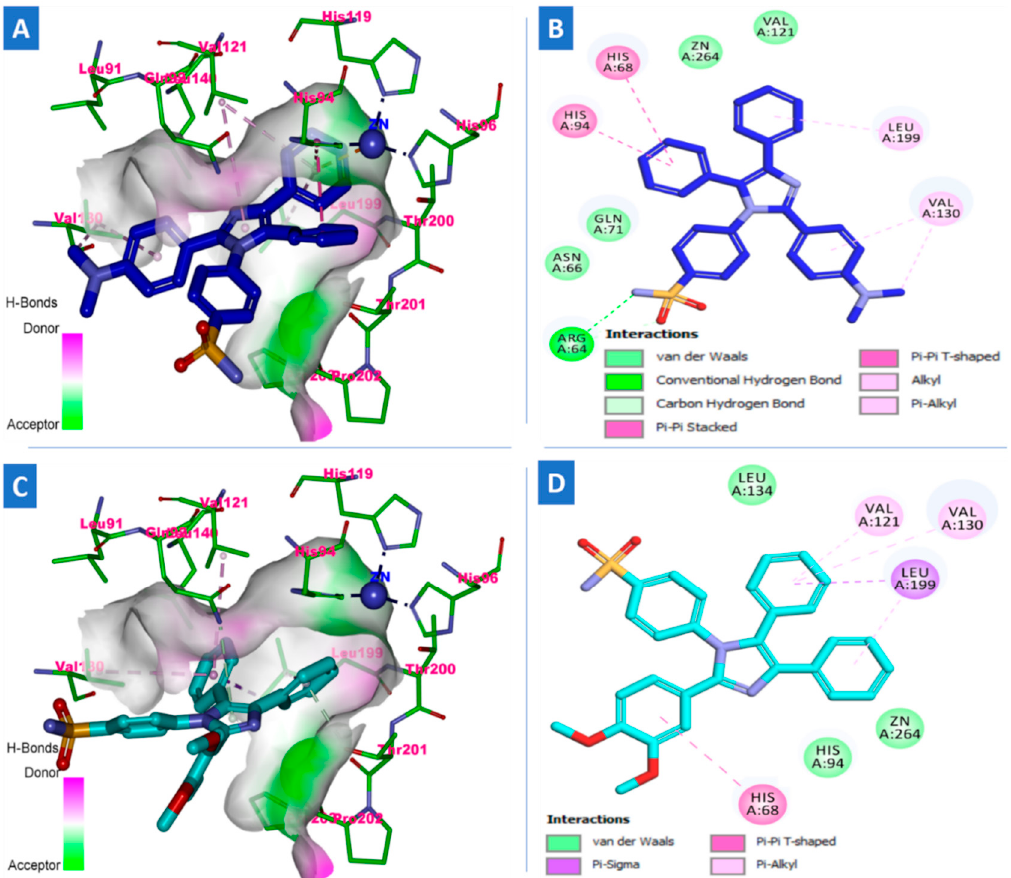
Figure 5. The docking and 2/3D binding modes of compound 5k (stick with carbons colored in blue) and compound 5i (stick with carbons colored in cyan) within the catalytic active site of CA-IX isoenzyme (PDB code: 5FL4); ( A ) 3D binding mode of compound 5k into active site of CA-IX isoenzyme; ( B ) 2D docking mode of 5i showing different types of interactions inside the active site of CA-IX isoenzyme; ( C ) 3D binding mode of compound 5i into active site of CA-IX isoenzyme; ( D ) 2D docking mode of 5i showing different types of interactions inside the active site of CA-IX isoenzyme. Zn 2+ cation is presented as a blue sphere in coordination with His94, His96, His119 and -NHSO 2 shown in dashed dark blue lines. H-bonds are represented as dashed green lines. All hydrogens were removed for the purpose of clarity.